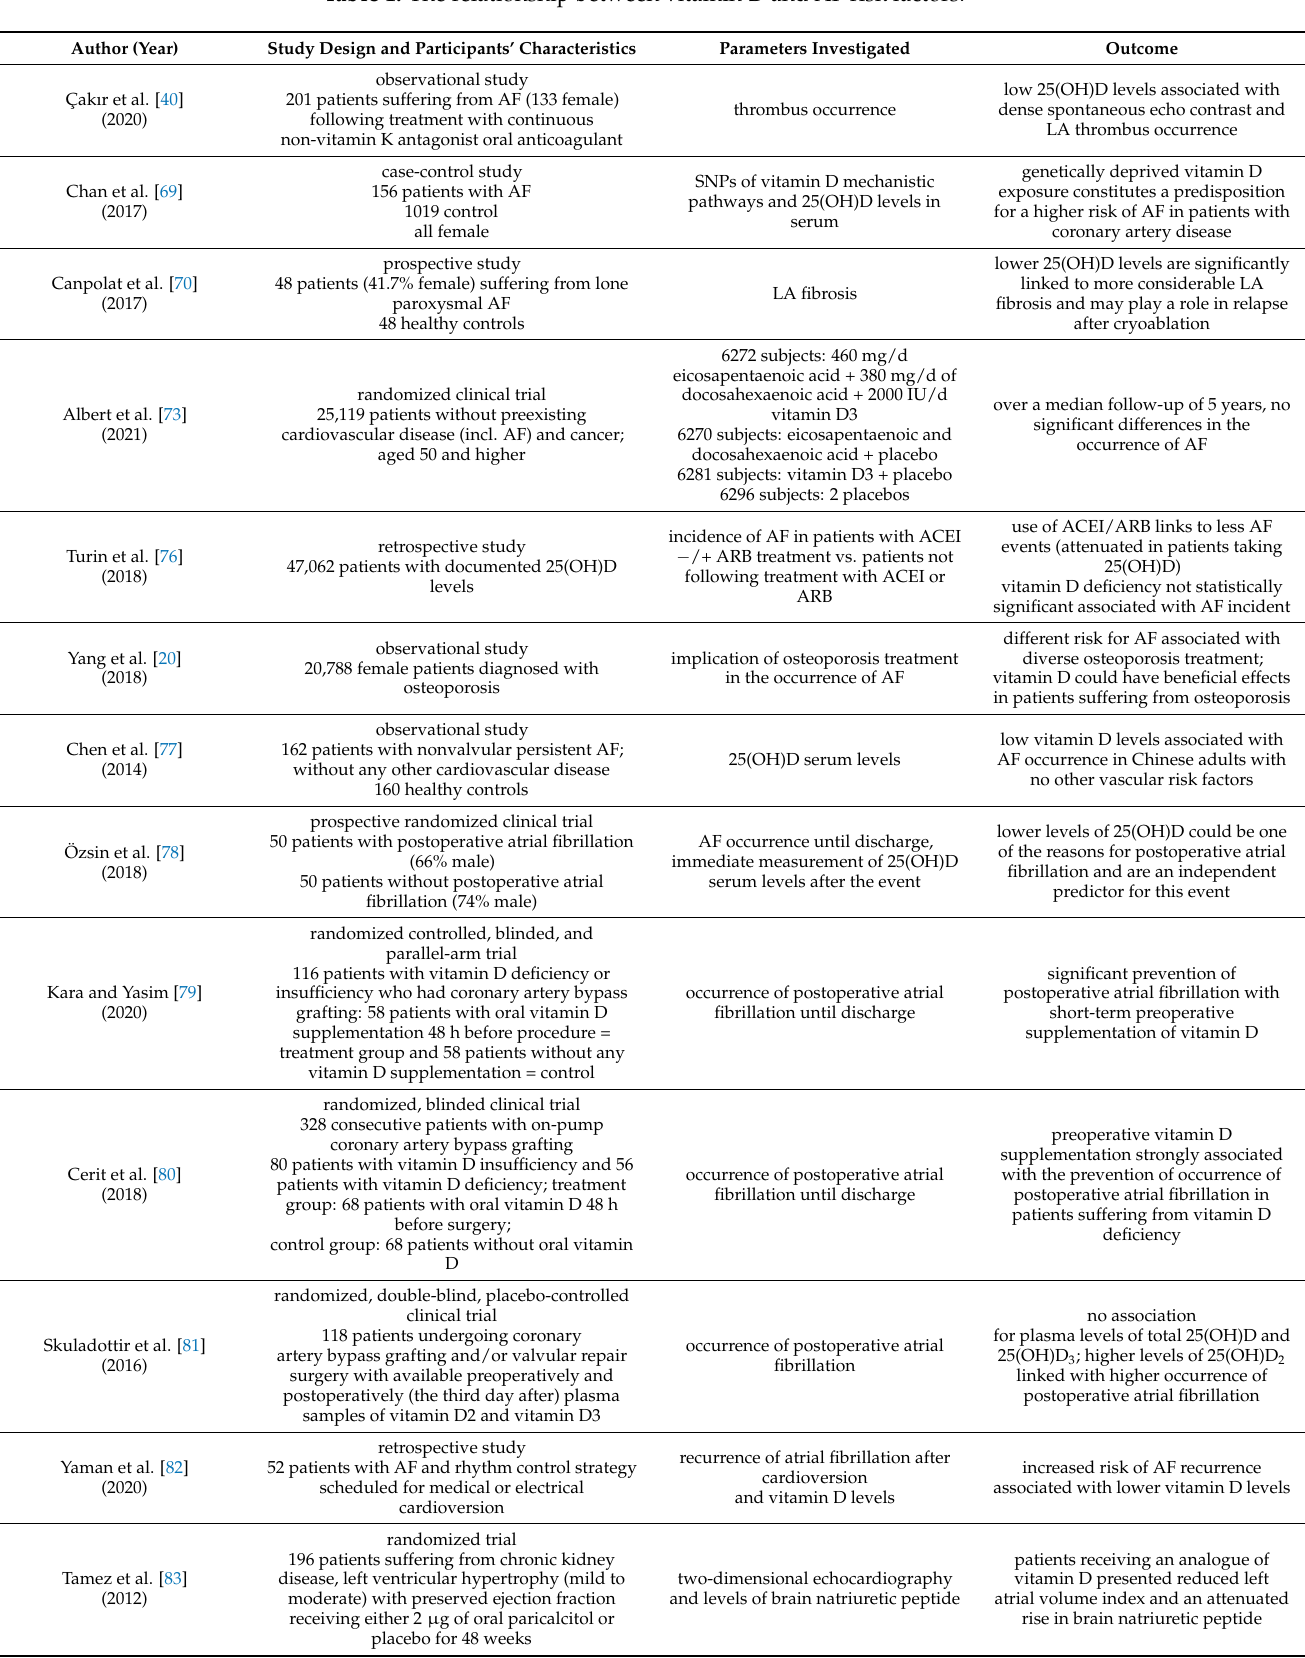
Table 1. The relationship between vitamin D and AF risk